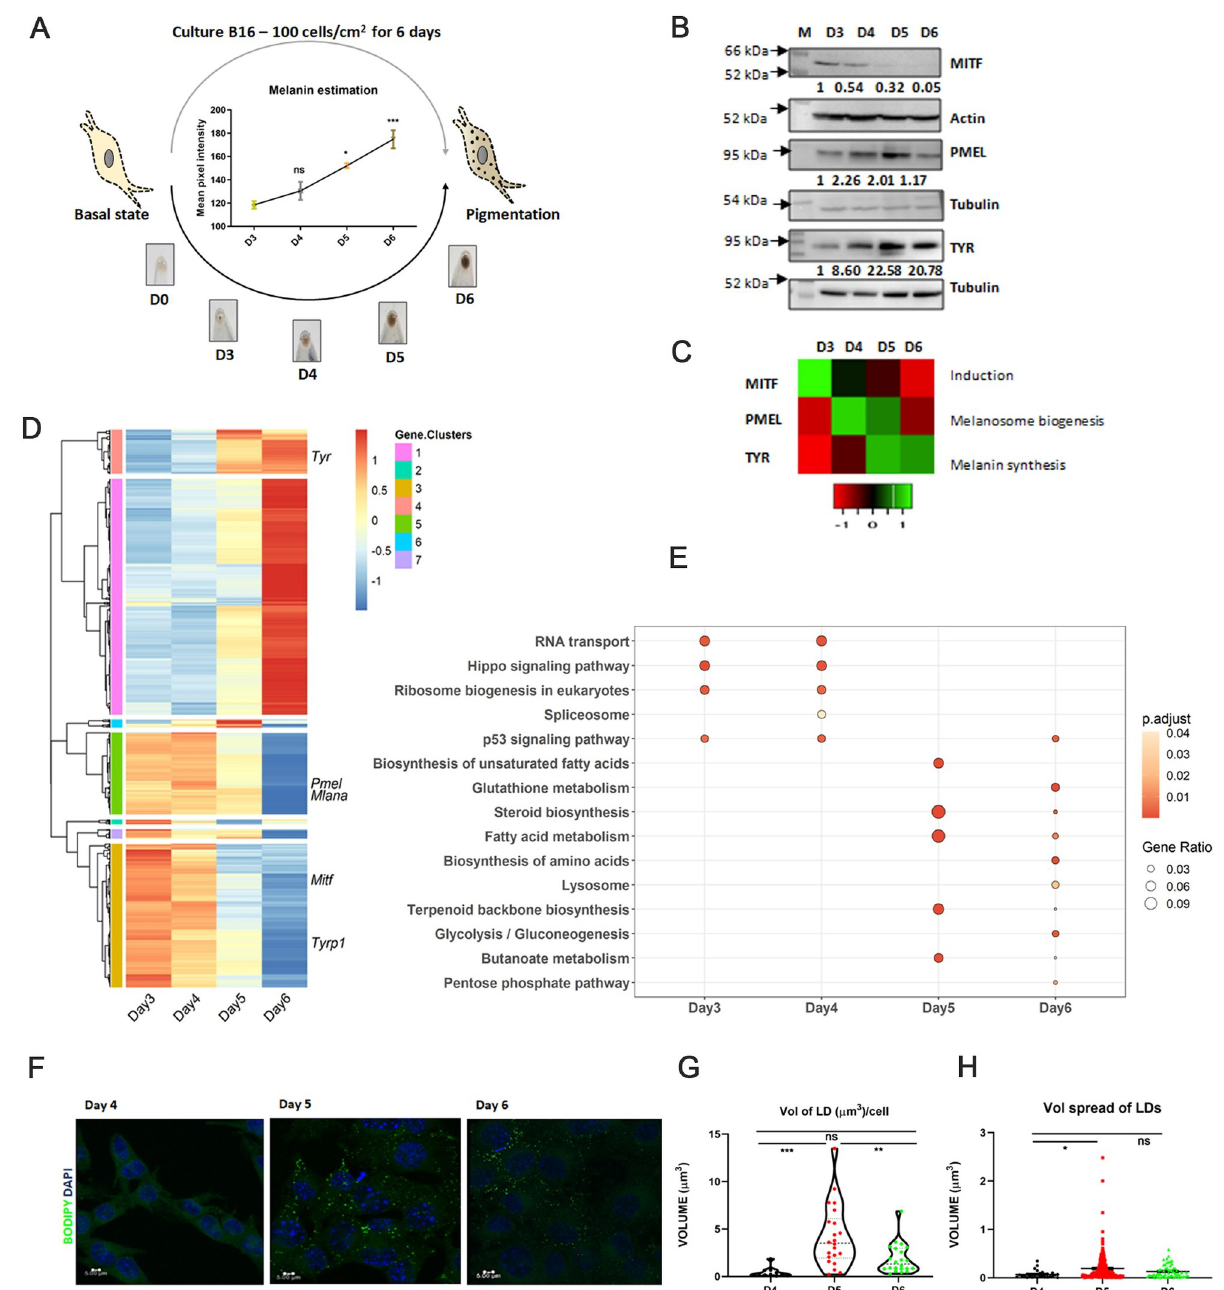
Fig 1. Melanogenesis is coupled to transcriptional activation of metabolic genes. (A) Schematic diagram illustrating the assay setup where culturing B16 cells at low density of 100 cells/cm 2 (Top) results in the transition of melanocyte from depigmented (day 0) to pigmented state (day 6) as shown in the pellet images ( N = 3) (Bottom). Quantitative analysis of melanin intensity of the pellets is shown in the line graph (Between). Mean ± SEM is plotted for 3 biological replicates. One-way ANOVA is applied, F(3,8) = 18.28. p -Value = 0.0006. Turkey’s test is performed for pairwise comparison. ( B) Representative western blot of key pigmentation proteins, MITF, PMEL, TYR, and DCT on days 3 to 6 (D3 to D6) ( N = 3). Arrows mark the sizes of molecular weight markers written in kDa. Numerical values show average fold change for 3 biological replicates. ( C) Heatmap depicting relative mean expression levels of pigmentation proteins wrt D3 for 3 independent experiments. Scale from red to green represents the z-scores of fold change (below). ( D) Heatmap represents 1,493 DEGs with an adjusted p -value < 0.001 obtained from time-course analysis performed using the LRT test for 2 independent biological replicates. Scale from blue to red represents z-score from –1 to +1. Hierarchical clustering was performed on the expression data of 1,493 DEGs into 7 clusters. ( E) KEGG pathway enrichment analysis was done for DEGs with adjusted p -value < 0.001 up-regulated on days 3, 4, 5, and 6. Bubble plot depicts the enrichment of pathways on different days, where the size of bubble represents the gene ratio and colour represents the p -value. ( F) Representative confocal microscopy images show lipid droplet accumulation in B16 cells during pigmentation. Images were taken at